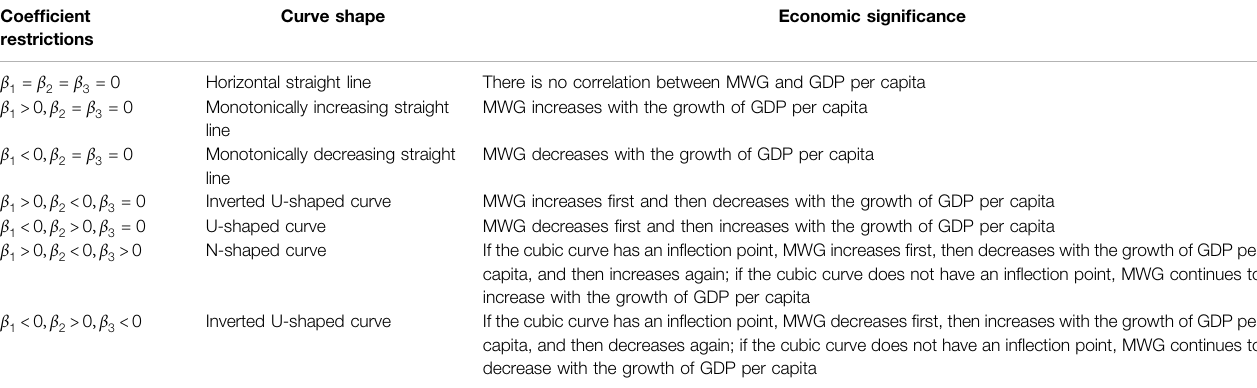
TABLE 4 | The estimated coef fi cients, curve shape and economic signi fi cance of EKC model. Coef fi cient